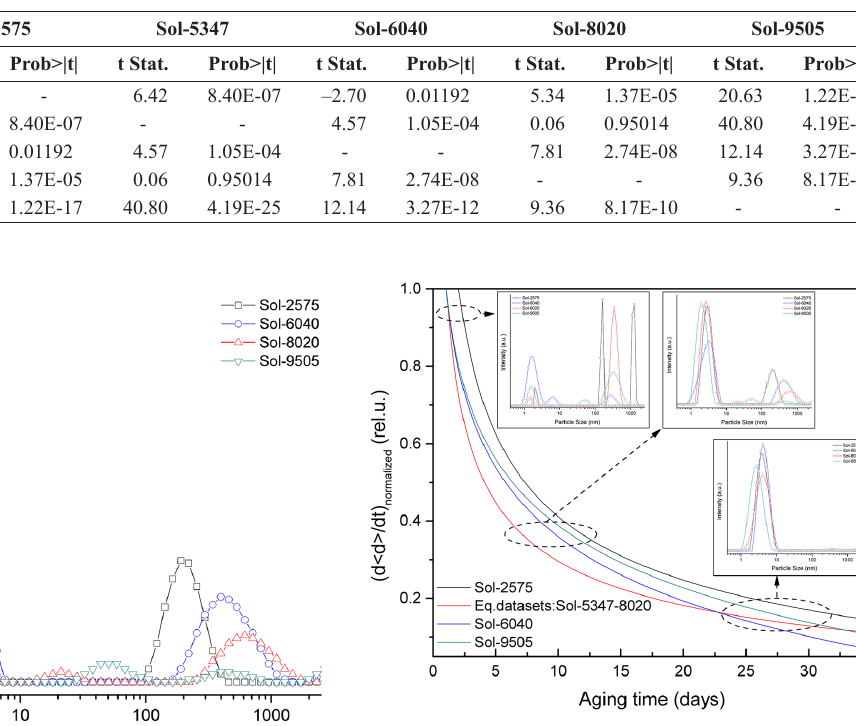
Table 2. Fitting parameters for the NLLSF made to our datasets based on a DLCA aggregation model.